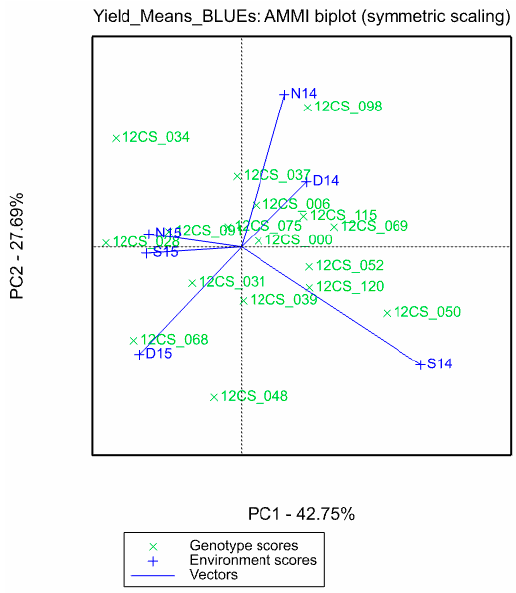
Figure 3. Additive main effects and multiplicative interaction (AMMI) biplot for pod yield using 16 CSSLs and Fleur11 tested in six environments. Genotypes are represented in green and environments in blue. Fleur11 is referred to as 12CS_000.